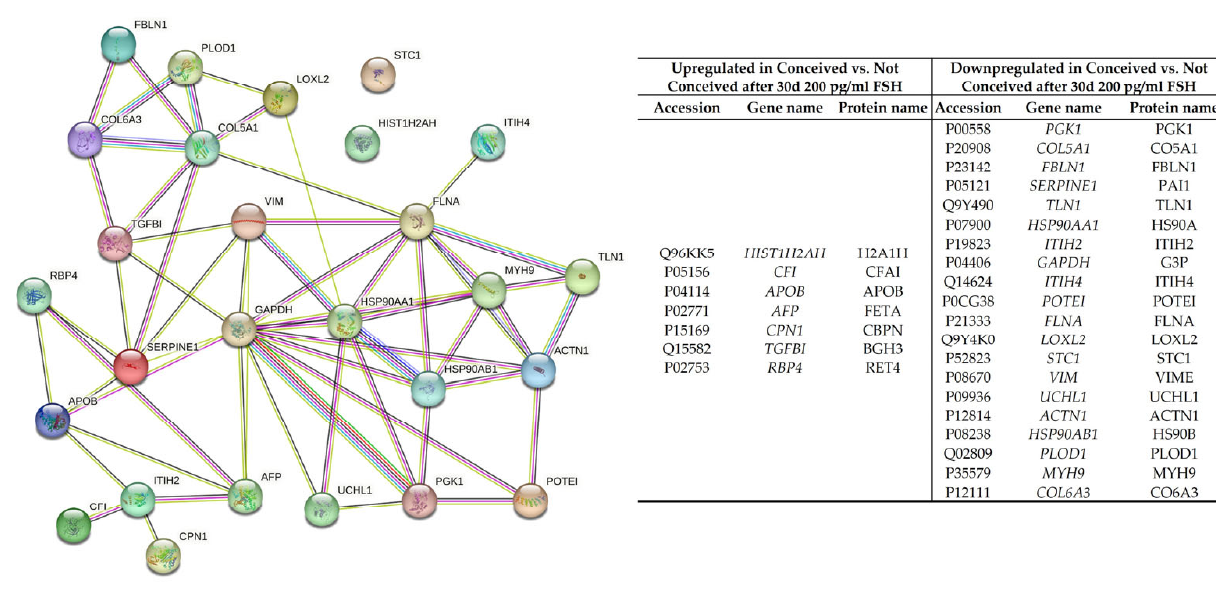
Figure 6. Differently secreted proteins in conceived and not-conceived patients’ FF stromal cells after 30 days of exposure to 200 pg/mL FSH. The interaction networks of secreted proteins and their involvement in different biological processes were identified using the STRING database, available online at https://string-db.org/ (accessed on 9 November 2022).